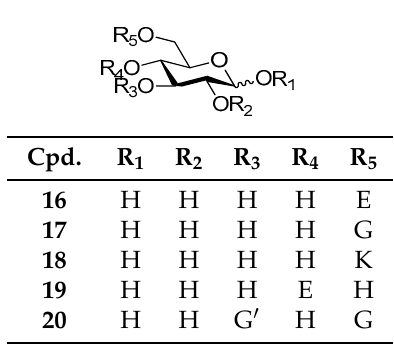
Figure 3. Structures of compounds 11 – 15 .